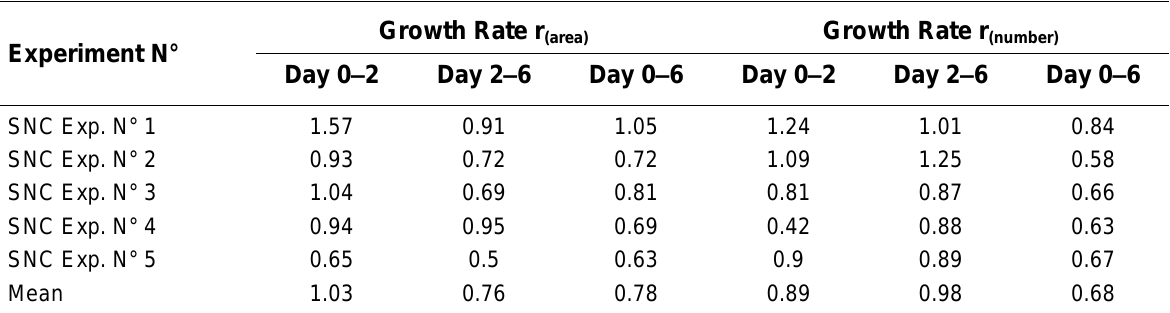
Coefficient of Variation (CV)* for Each Outcome Parameter in the Five Systematic Negative Control